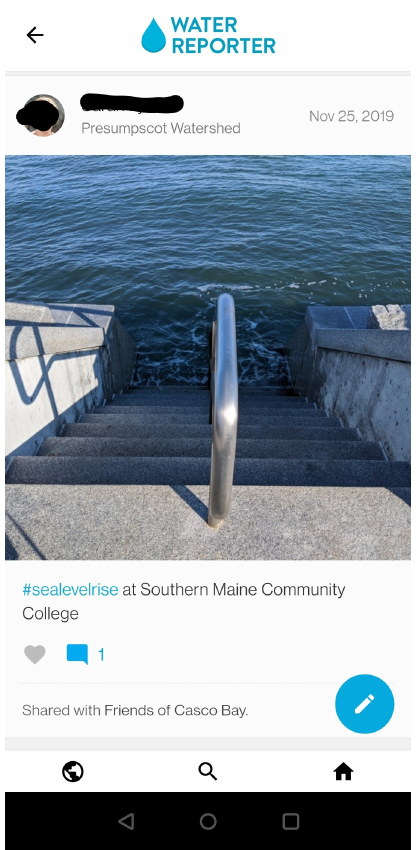
Figure 1. Screenshot of Water Reporter